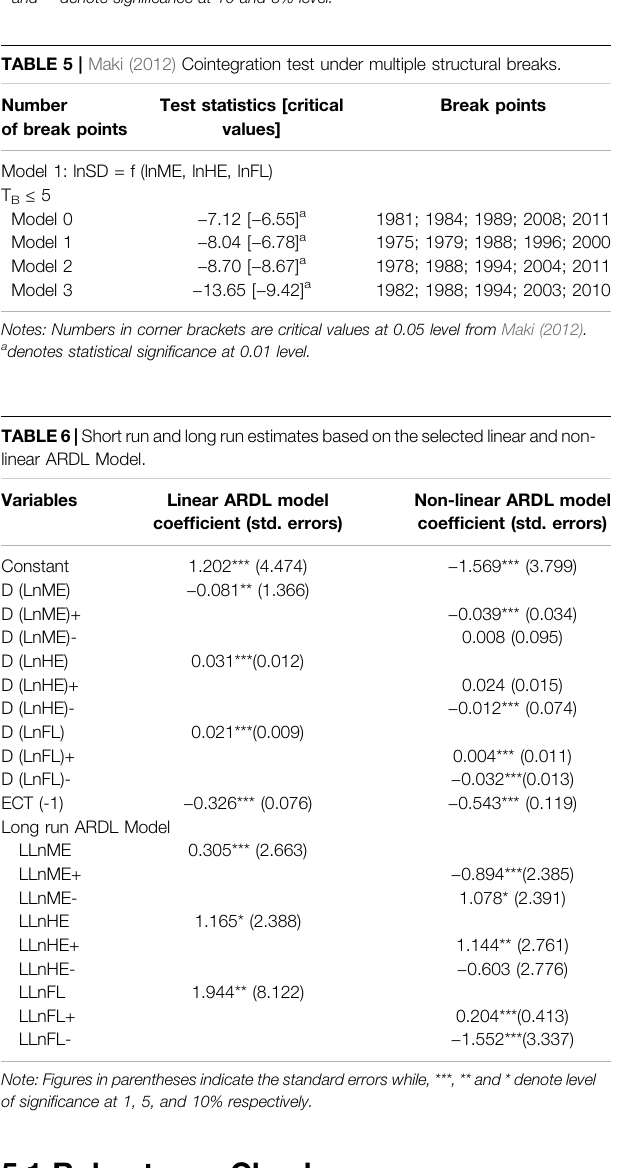
* and ** denote signi fi cance at 10 and 5% level.